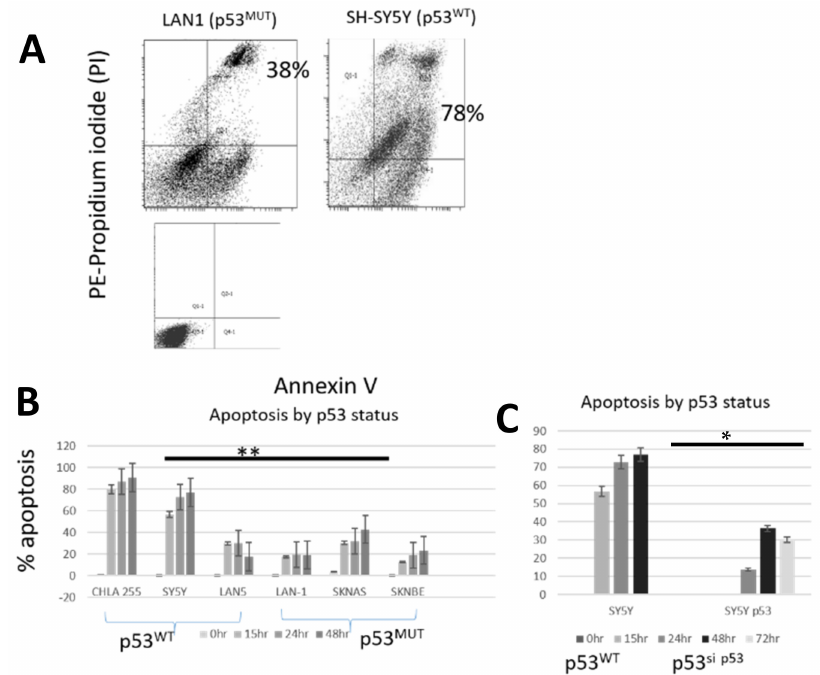
Figure 2. Apoptosis in neuroblastoma cell lines after treatment with pevonedistat at the IC50. ( A ) Annexin/PI staining in representative cell lines plus control. Annexin measured by +/+ i.e., positive for both annexin and PI. ( B ) Apoptosis by p53 status. ( C ) Apoptosis in SH-SY5Yand SH-SY5Y p53 knock down cell lines. ** p < 0.01; * p < 0.05. Data is representative of repeat